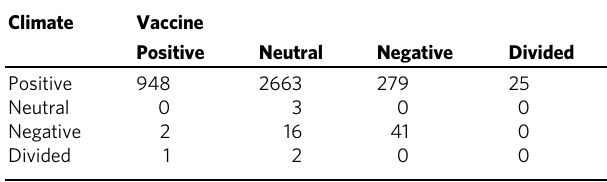
Table 3 Many pro-climate users are anti-vaccine, but the converse is not